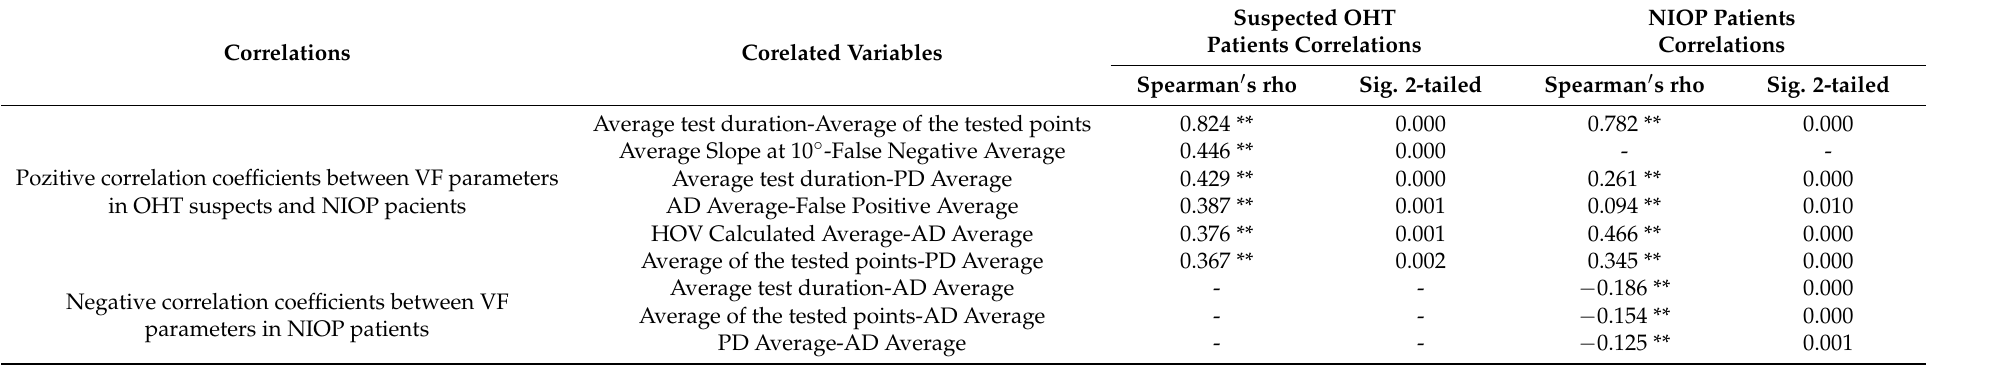
Table 7. The comparative distribution of positive and negative correlation coefficients between VF parameters in OHT suspects and NIOP